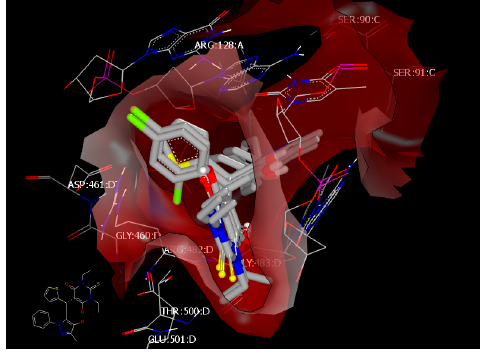
Figure 7. Visual representation of compounds 4c , 4o , and 4l docked with 5BTC, showing no hydrogen bond interaction, as shown by Vida.